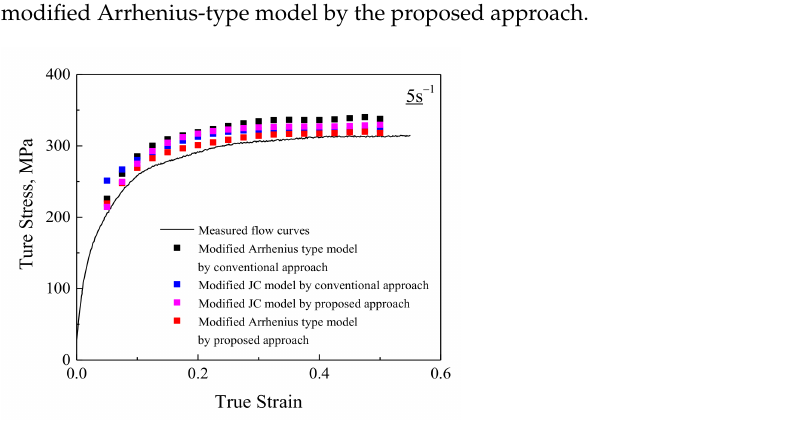
Figure 5. Evaluation of the developed constitutive models through the measured data after deforma- tion at the 650 ◦ C and 5 s − 1